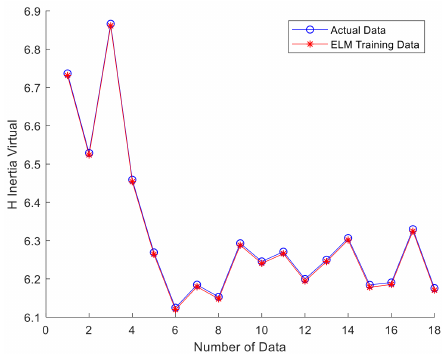
Figure 9. Comparison of actual H data and ELM H